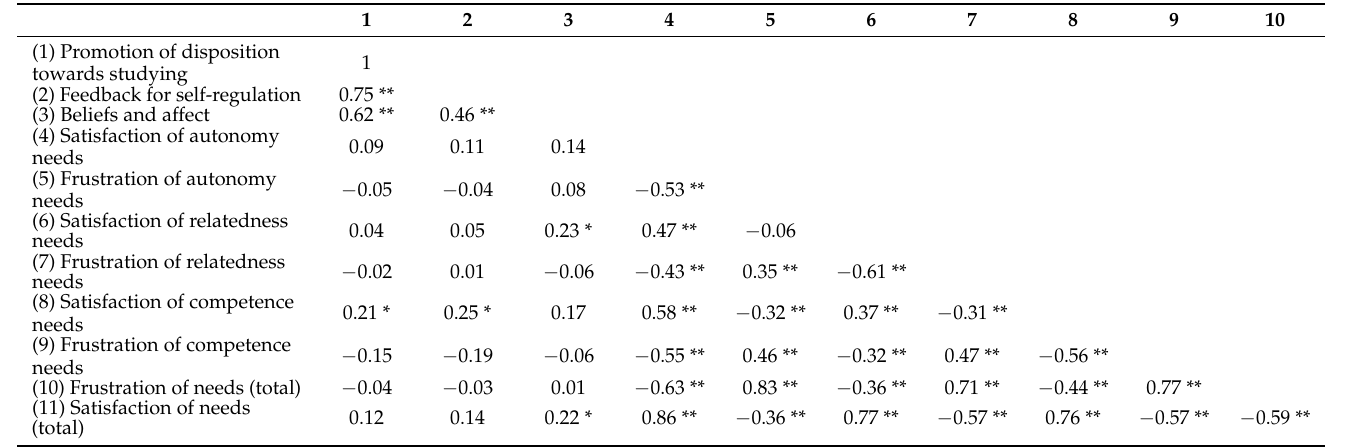
Table 2. Correlations among studied variables.